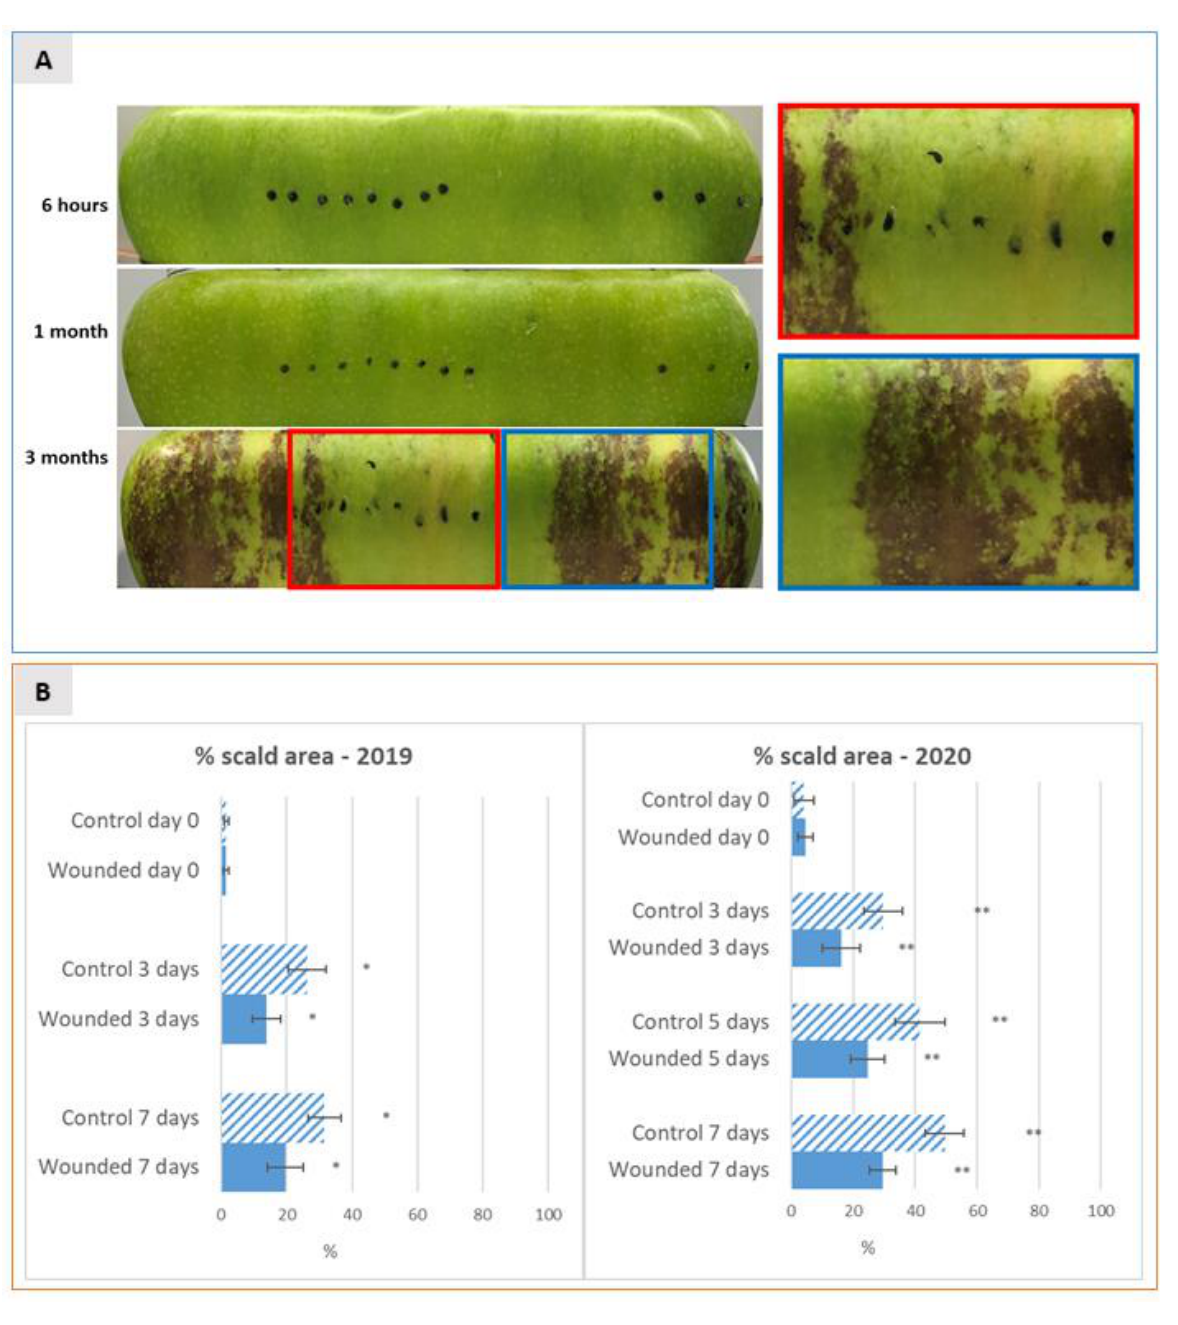
Figure 1. ( A ) 2D pictures of the entire surface of Granny Smith apples at six hours after wounding (before storage) and after one and three months of cold storage (1.7 °C) followed by 8 days of shelf life. Pictures were taken at 3, 5 and 8 days of shelf-life by two-dimensional acquisition of the entire apple surface as described in materials and methods. Representative pictures are shown at the 8th day of shelf life, when symptoms of scald development became clearly visible. Black dots were applied on the apple surface to highlight the exact sites where wounding was performed. The right panel in A shows an enlargement of the boxed insets, to give a close-up view of the difference in terms of scald development between the wounded (red box) and the unwounded (blue box) areas of the apple surface after three months of storage followed by 8 days of shelf-life. ( B ) Dynamics of superficial scald incidence were expressed as mean percentage (±SD) of browned scald area over the total apple surface, measured on a total number of 10 (2019) and 20 (2020) independent apples (replicates) for each thesis after three months of cold storage and evaluated by 2D acquisition at different time-points of shelf-life over a period of 8 days (at 0, 3 and 8 days in 2019 and at 0, 3, 5 and 8 days in 2020). The incidence is shown separately for the wounded apple half versus non-wounded control half of apples. * and ** indicate a statistically significant difference between the means with a p -value of 0.1 and 0.05, respectively.